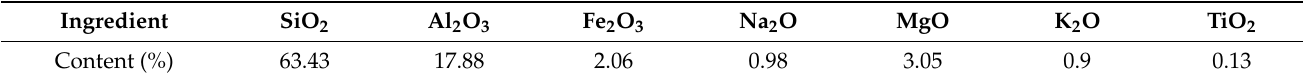
Table 1. Main chemical constituents of sodium bentonite.